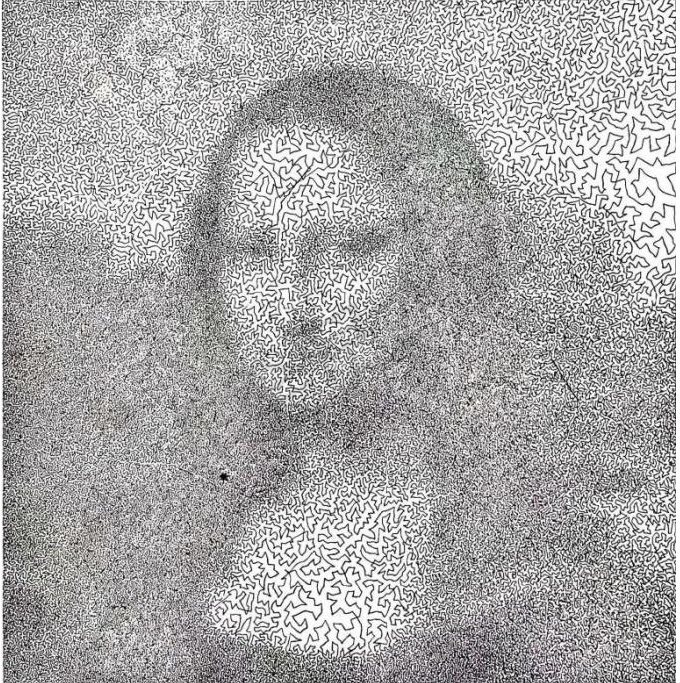
Figure 6. Three-layered structure and city groups’ connection